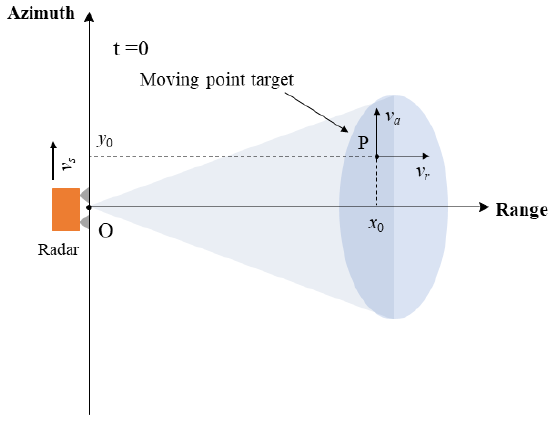
Figure 1. Geometry of the GBSAR and moving target.